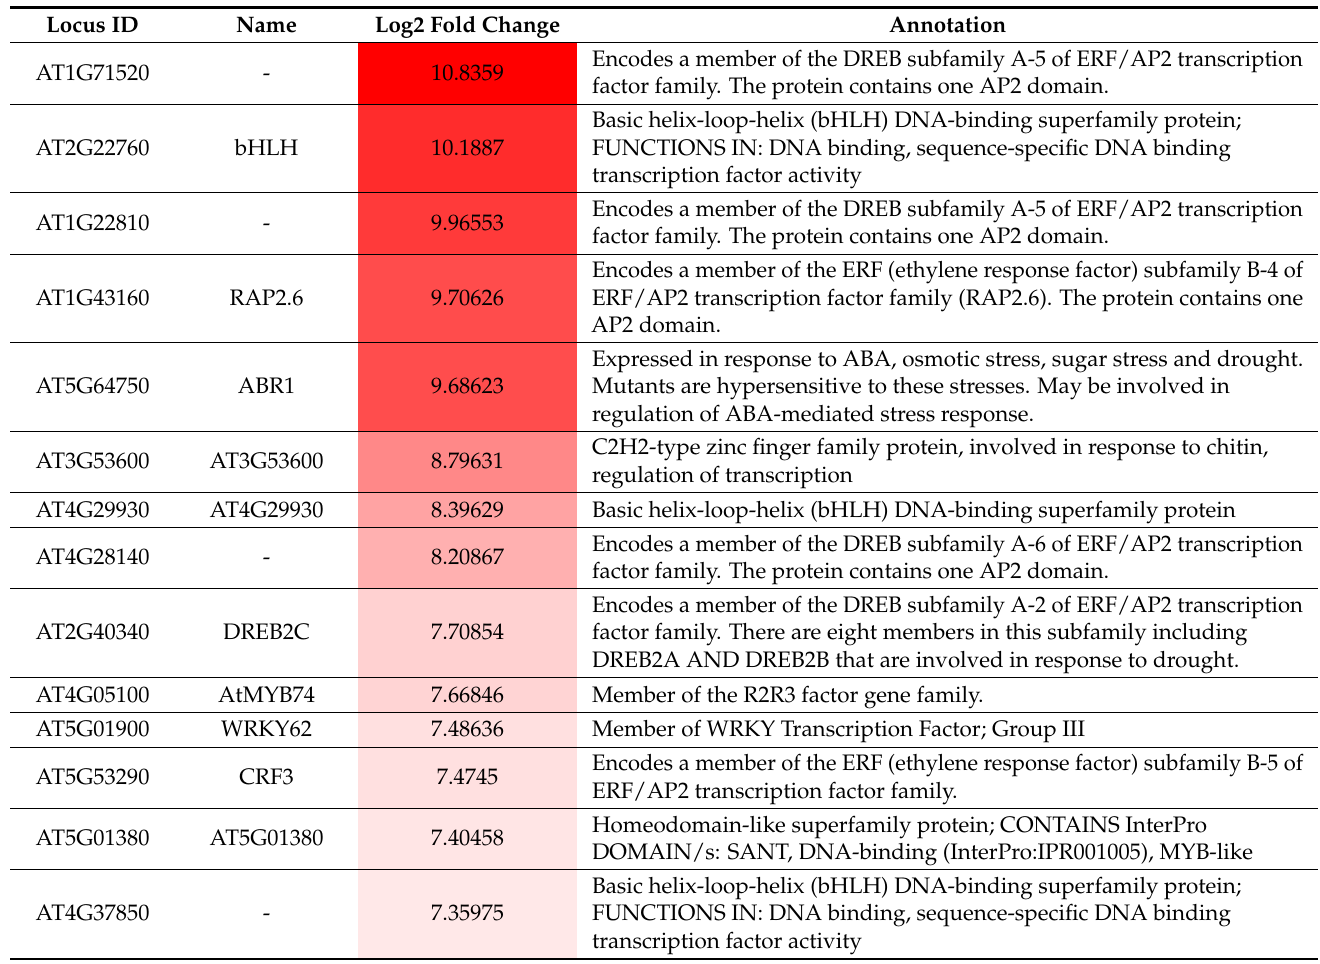
Table 1. List of top-20 up- and down-regulated transcription factors that showed differential expression in response to CySNO in RNA-seq based